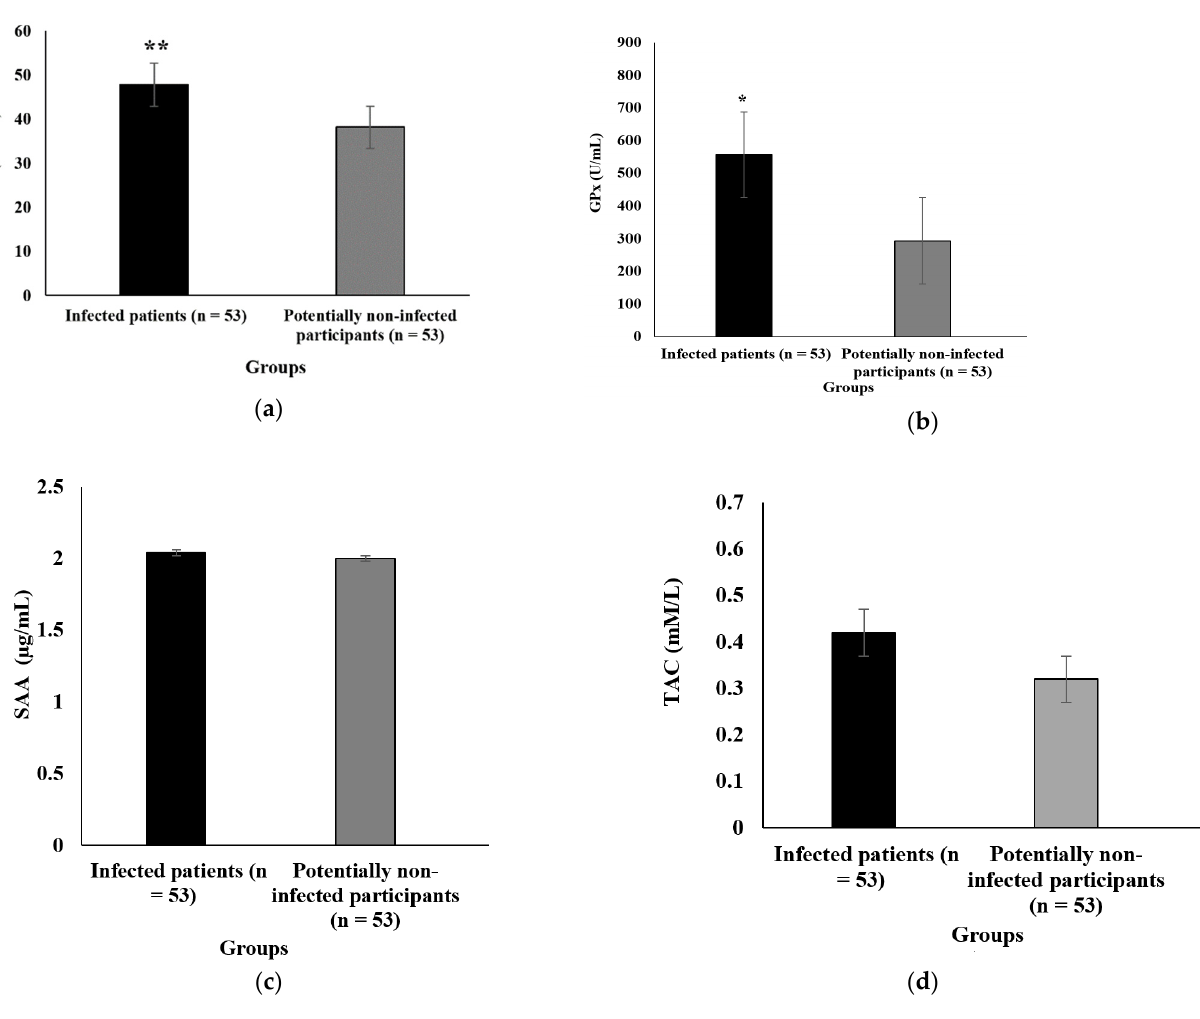
Figure 2. Comparison of serum concentrations of SOD ( a ), GPx ( b ), SAA ( c ), and TAC ( d ) in COVID-19 outpatients and controls before controlling for dietary supplement use. An independent sample t -test was applied to analyze data. SOD and GPx were significantly higher among COVID-19 outpatients than in controls. GPx, glutathione peroxidase; SAA, serum amyloid A; SOD, superoxide dismutase; TAC, total antioxidant capacity. * p = 0.001, ** p ≤ 0.001.